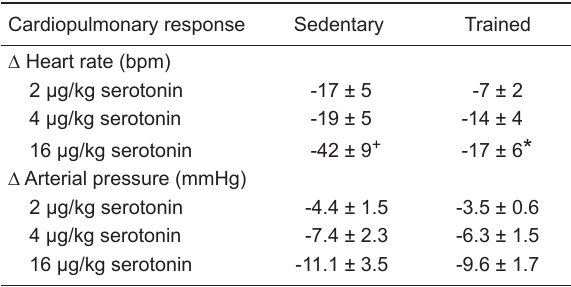
Table 2. Cardiopulmonary reflex responses of the sedentary and trained female